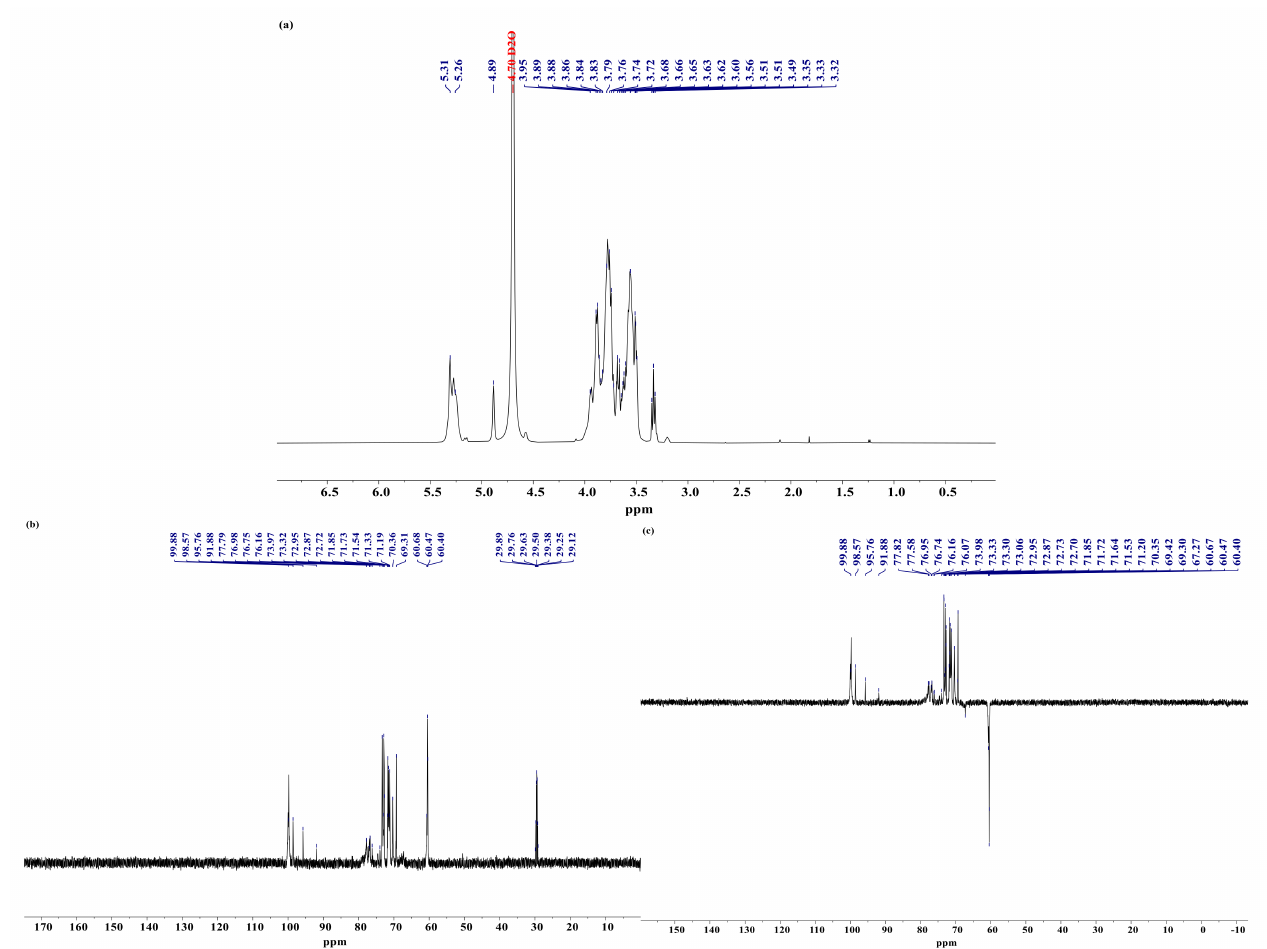
Figure 7. 1D-NMR spectrum of YPN. ( a ) 1 H-NMR; ( b ) 13 C-NMR; ( c ) 135